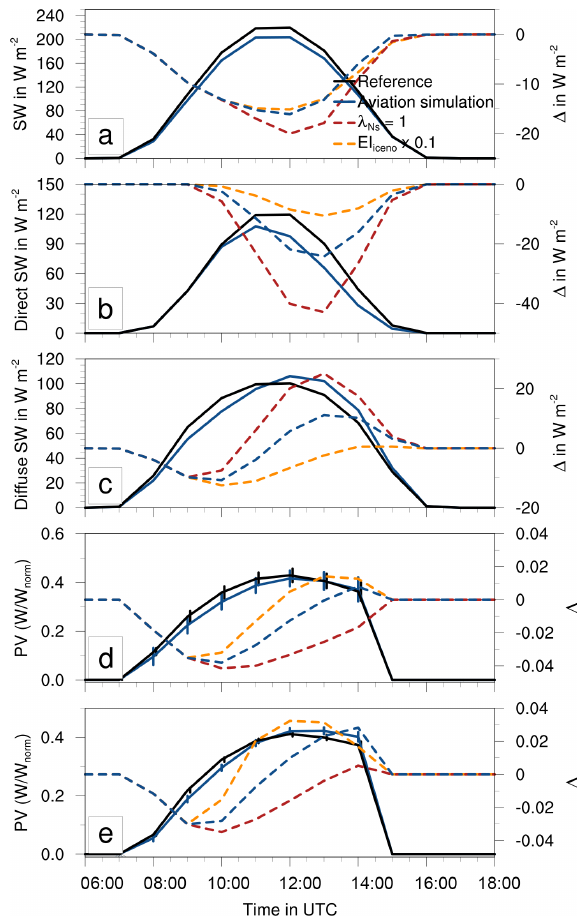
Figure 13. Temporal evolution for 3 December 2013 of incoming shortwave radiation: reference (black); aviation simulation as be- fore (blue); “bio-fuel” scenario with EI iceno × 0 . 1 (orange), omis- sion of crystal loss during contrail vortex phase with λ N Dashed lines (corresponding to right y axis) are difference to refer- ence simulation. (a) total SW; (b) direct SW; (c) diffuse SW; (d) , (e) normalized PV power. (a–d) Over entire domain; (e) mean for the location marked with the red circle in Fig. 12. Error bars represent mean values ± standard